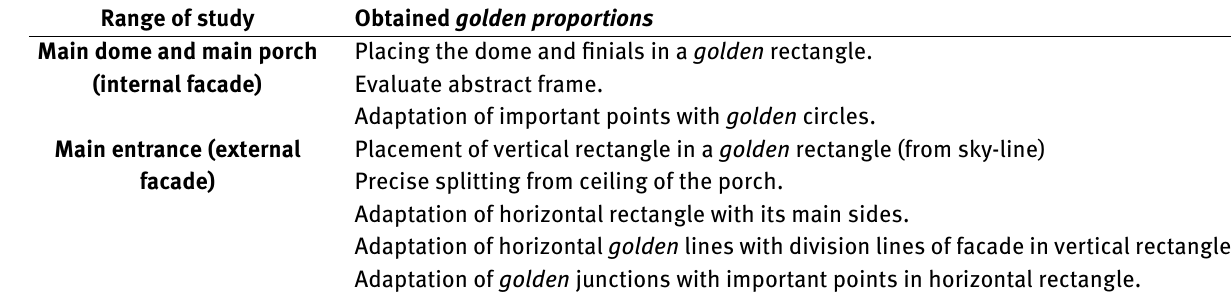
Table 3: Result of facade analysis Range of study Obtained golden proportions